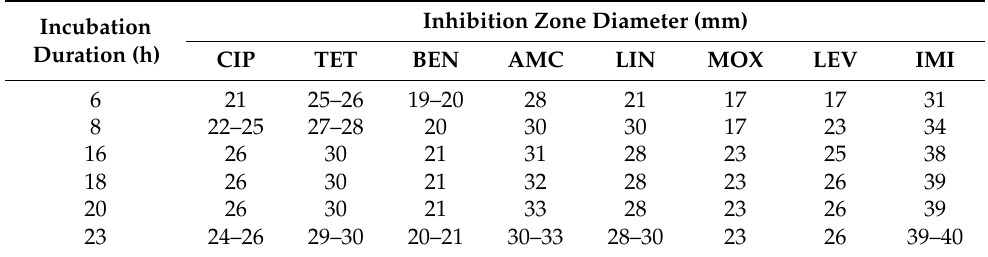
Table 2. Disc-diffusion inhibition zones of germinated B. anthracis spores at various time